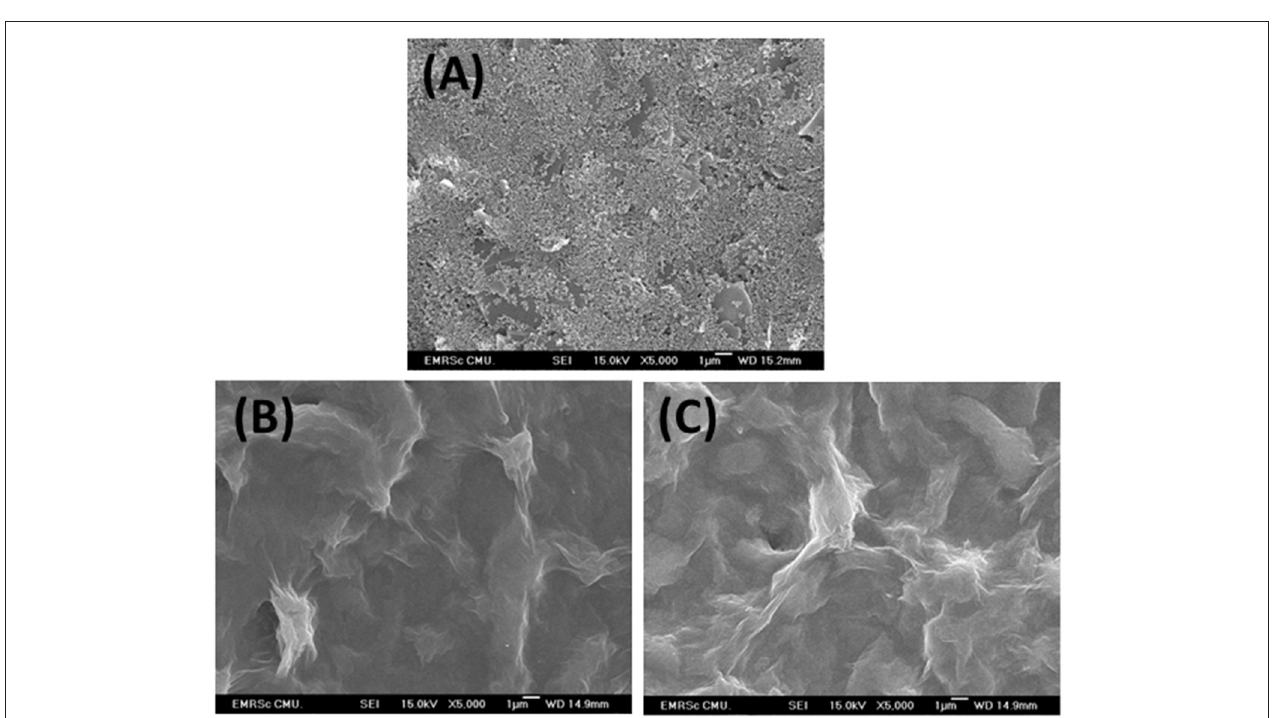
FIGURE 3 | FE-SEM images of bare SPCE (A) , GO-modified SPCE (B) , and Cu(II)/GO-modified SPCE (C) .